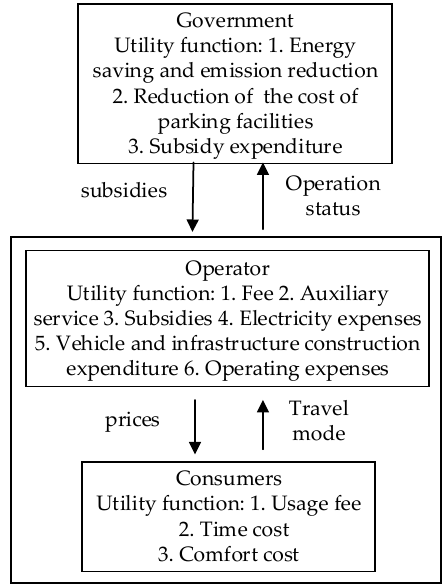
Figure 2. Framework of the two-stage Stackelberg game model.